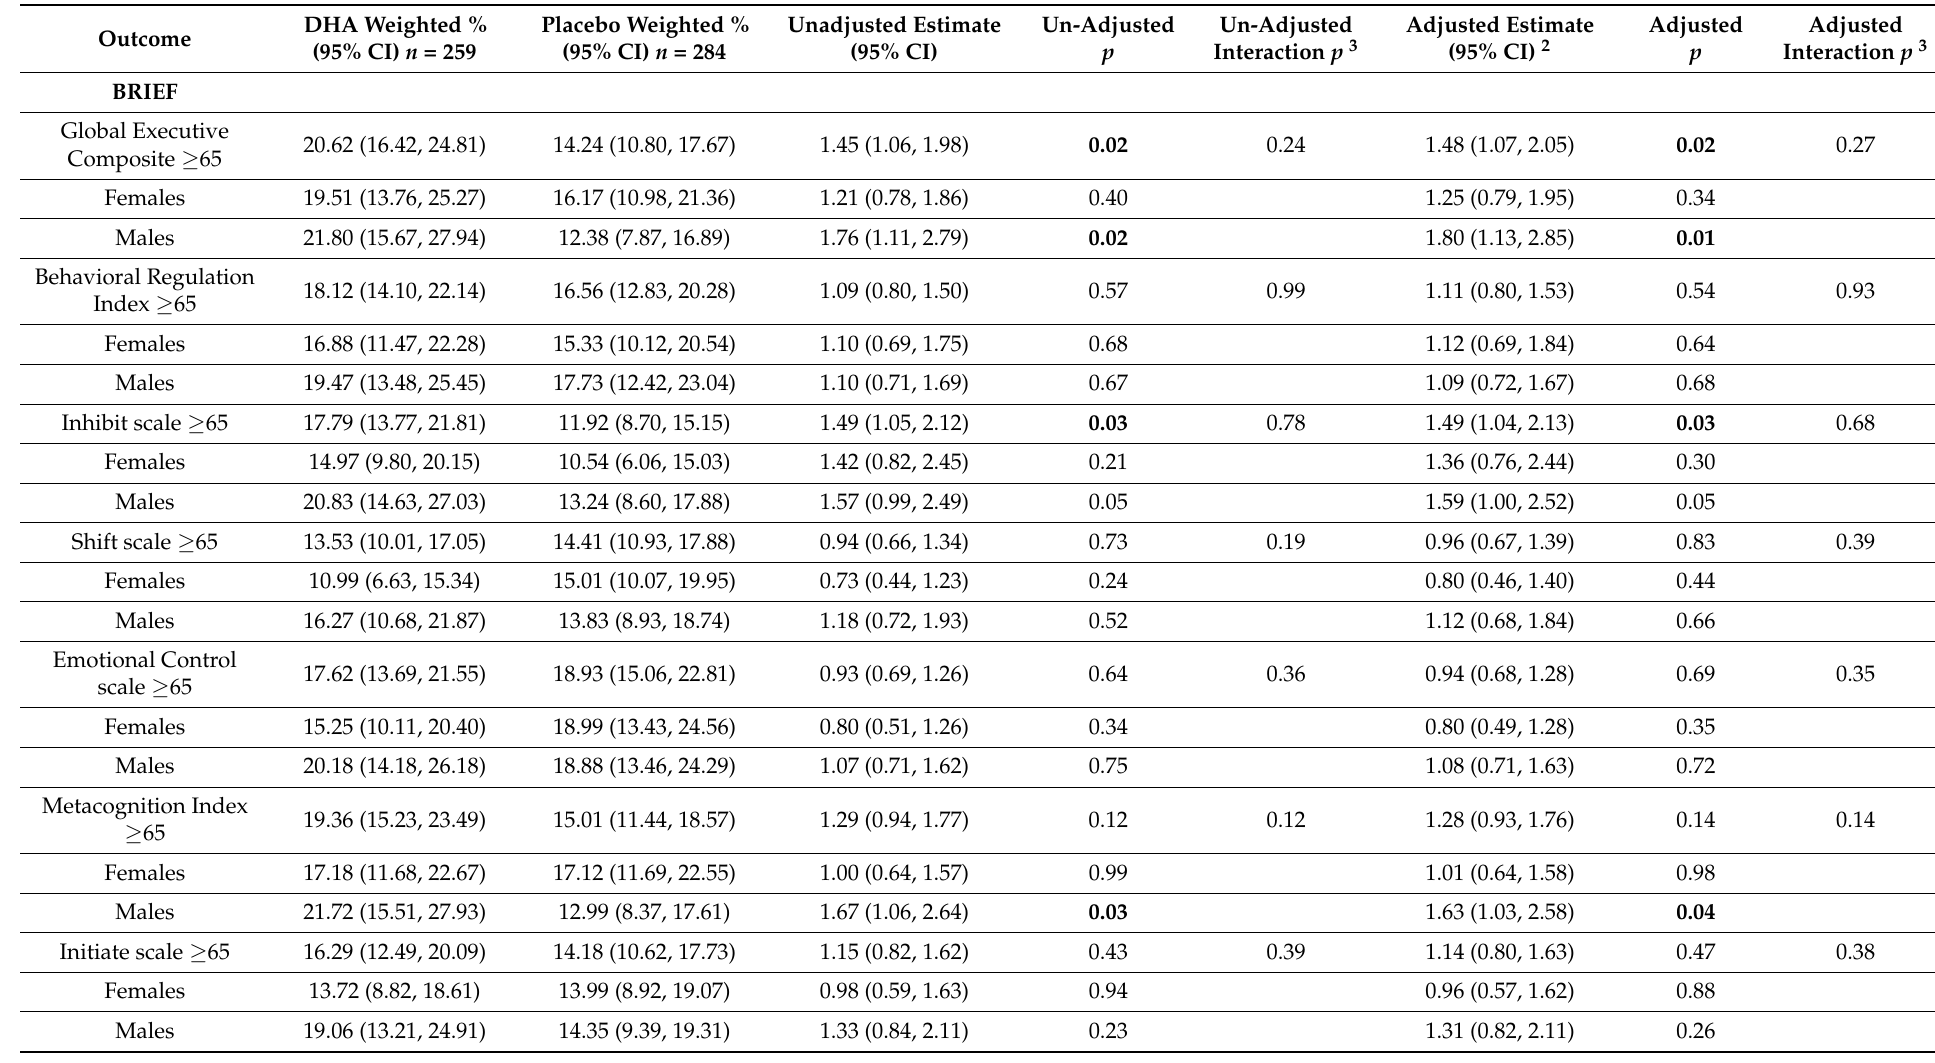
Table 3. Proportion of children with scores within the clinically significant range for behavior and behavioral manifestation of executive functions at 7 years of age 1 .